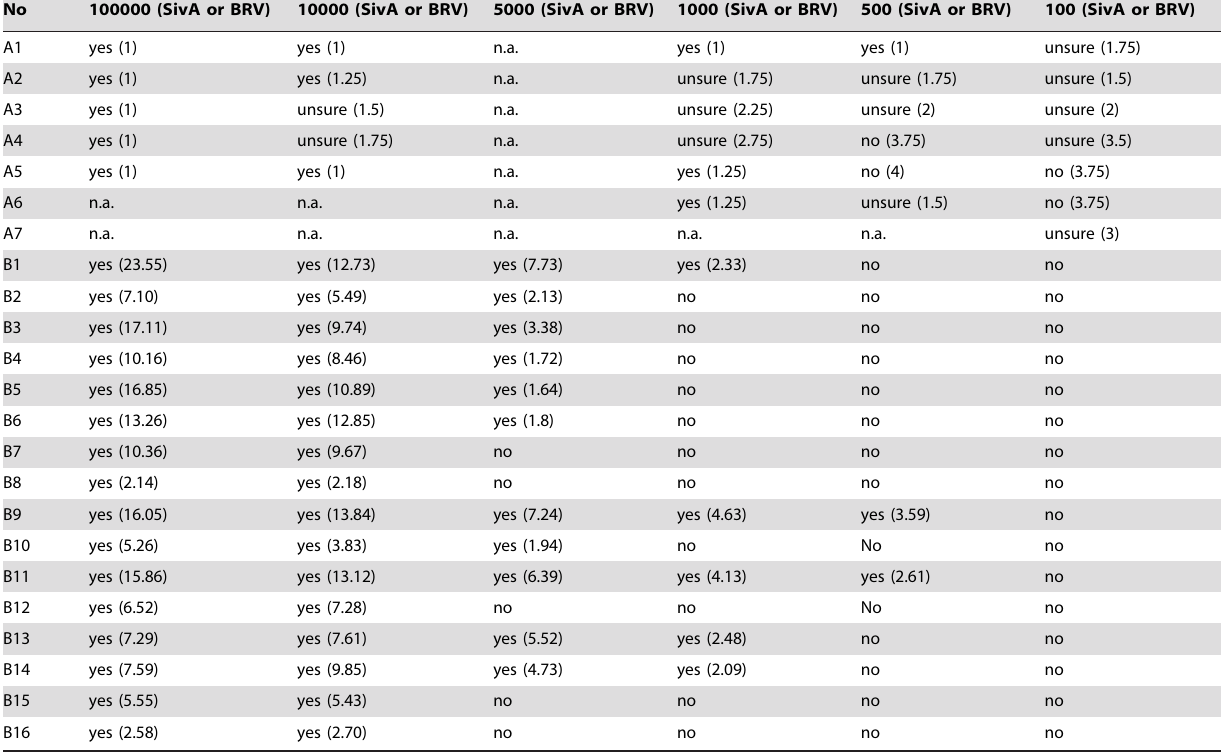
VSOP labeled cells significantly detectable